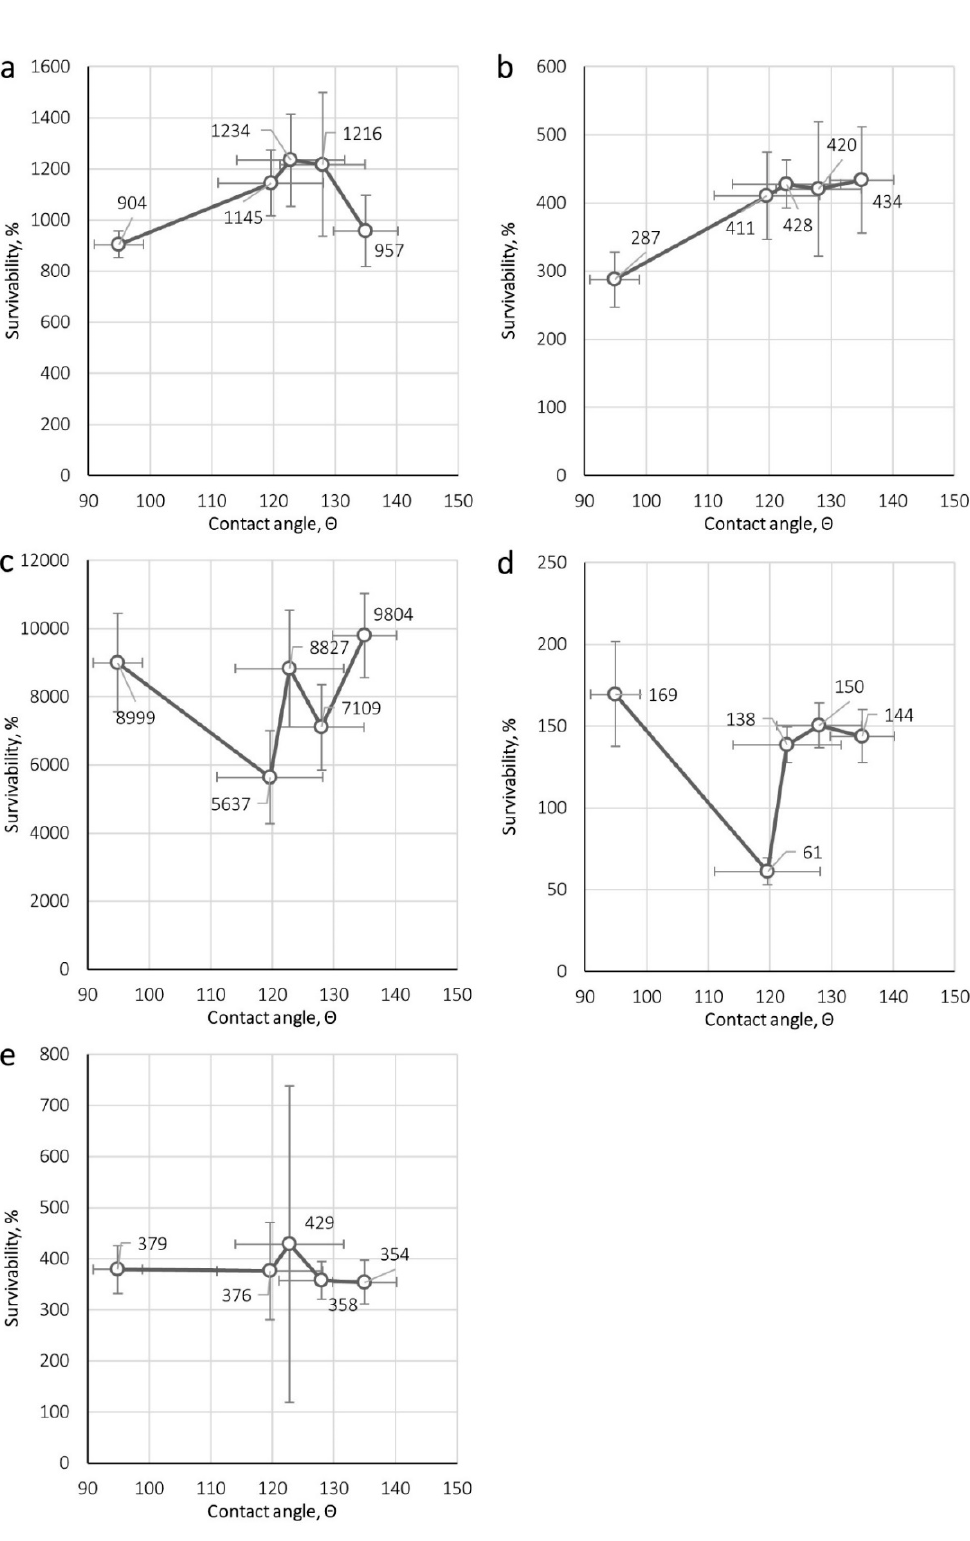
Figure 3. Dependence of the survivability of microorganisms on nonwoven contact angle for ( a ) E. coli , ( b ) S. aureus , ( c ) B. subtilis , ( d ) C. albicans , ( e ) A. niger .